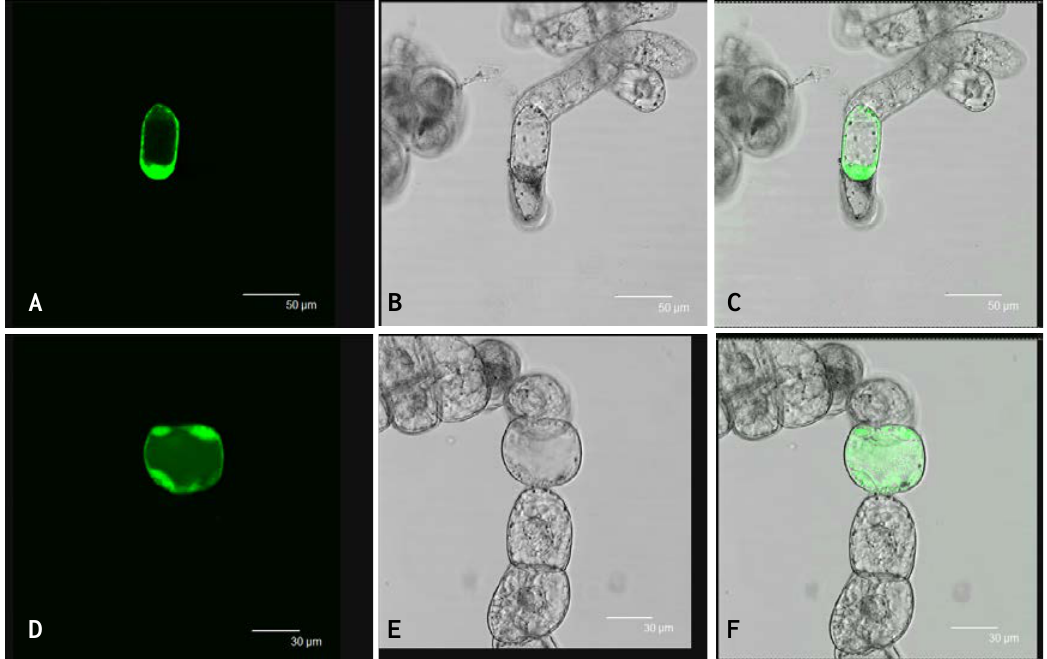
Figure 4. Subcellular localization of SpHyPRP1 protein in tobacco BY-2 cells. Tobacco BY-2 transiently transformed with construct containing vector plasmid 35S:: SpHyPRP1 - EGFP ( A – C ) and 35S:: EGFP ( D – F ). Images ( A , D ) are dark field and ( B , E ) are bright field and ( C , F ) combined.